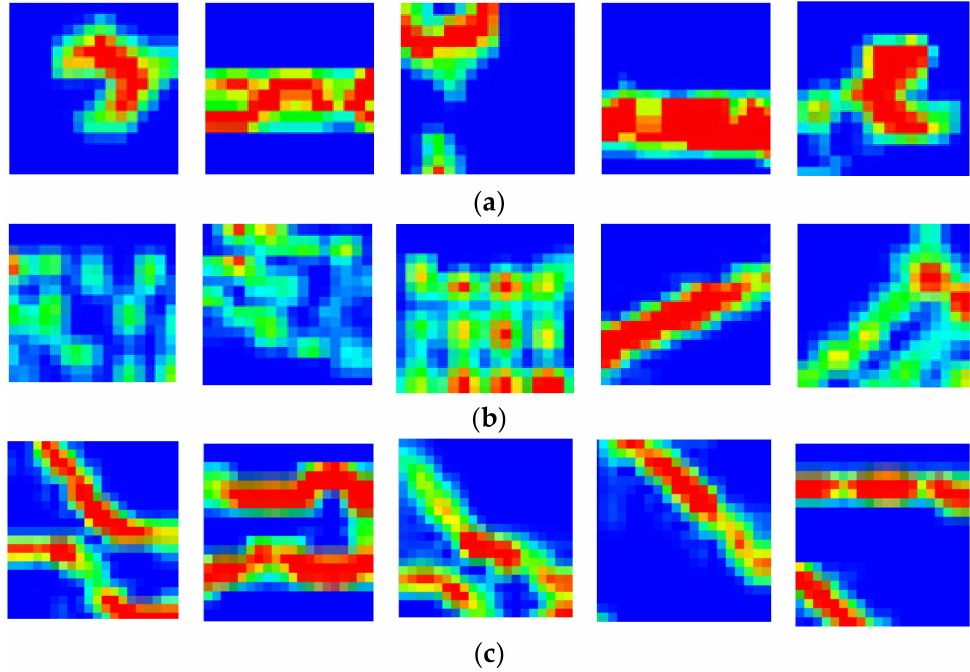
Figure 14. Sample tactile images: ( a ) a fixed wrench; ( b ) a remote controller; ( c ) plastic